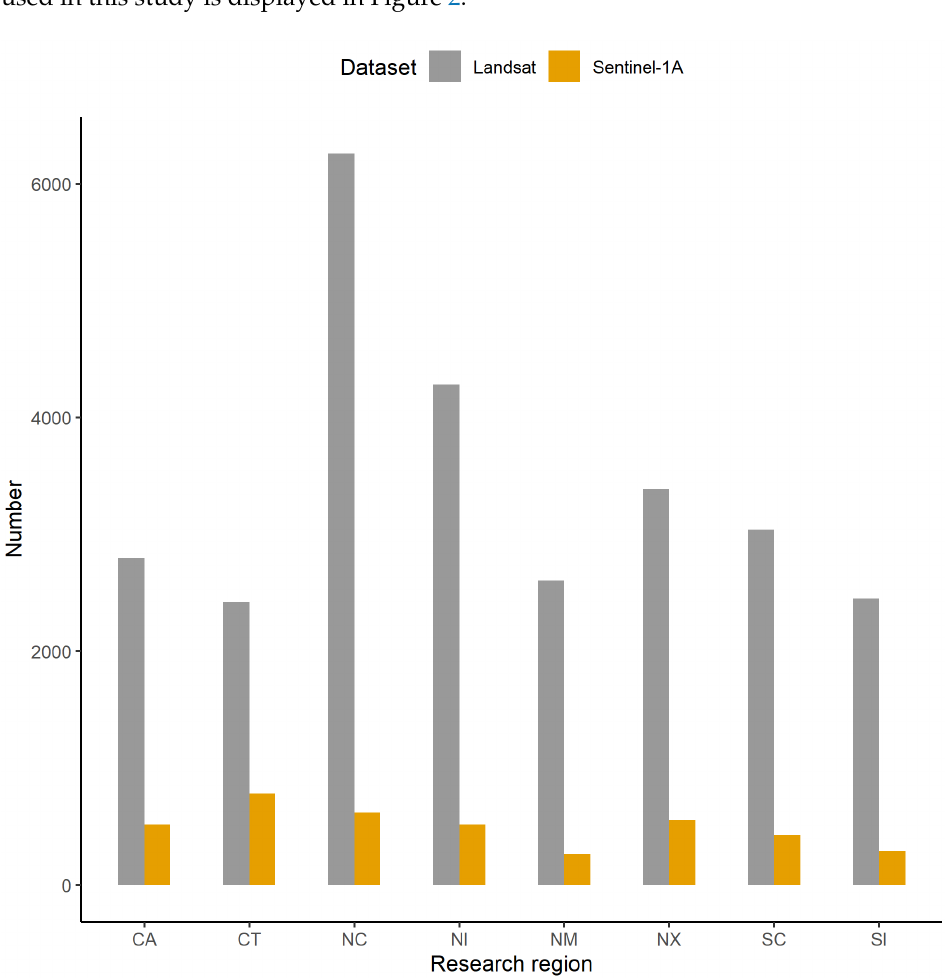
Figure 2. The number of Landsat and Sentinel images used in this study.